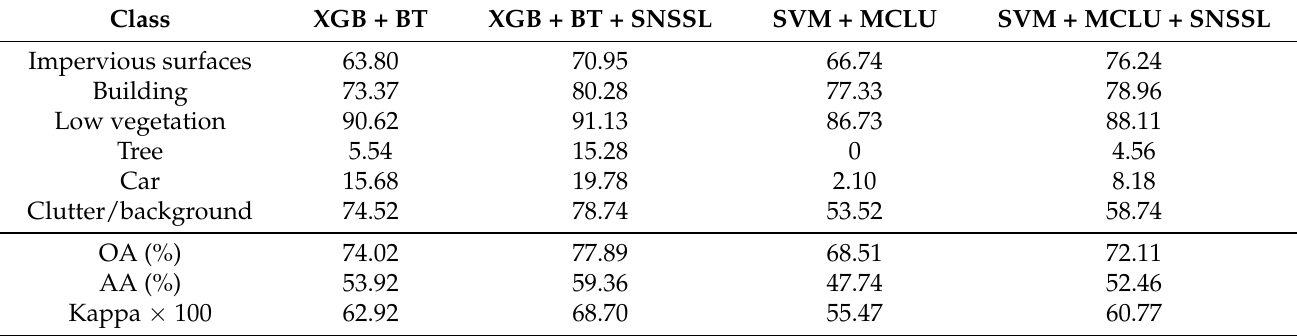
Table 5. Classification accuracy (averaged on 5 runs) of the